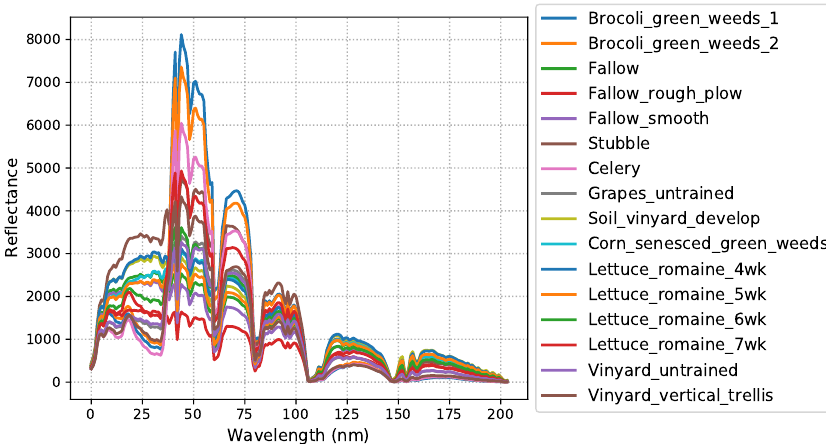
Figure 4. Land cover category of Pavia University dataset.